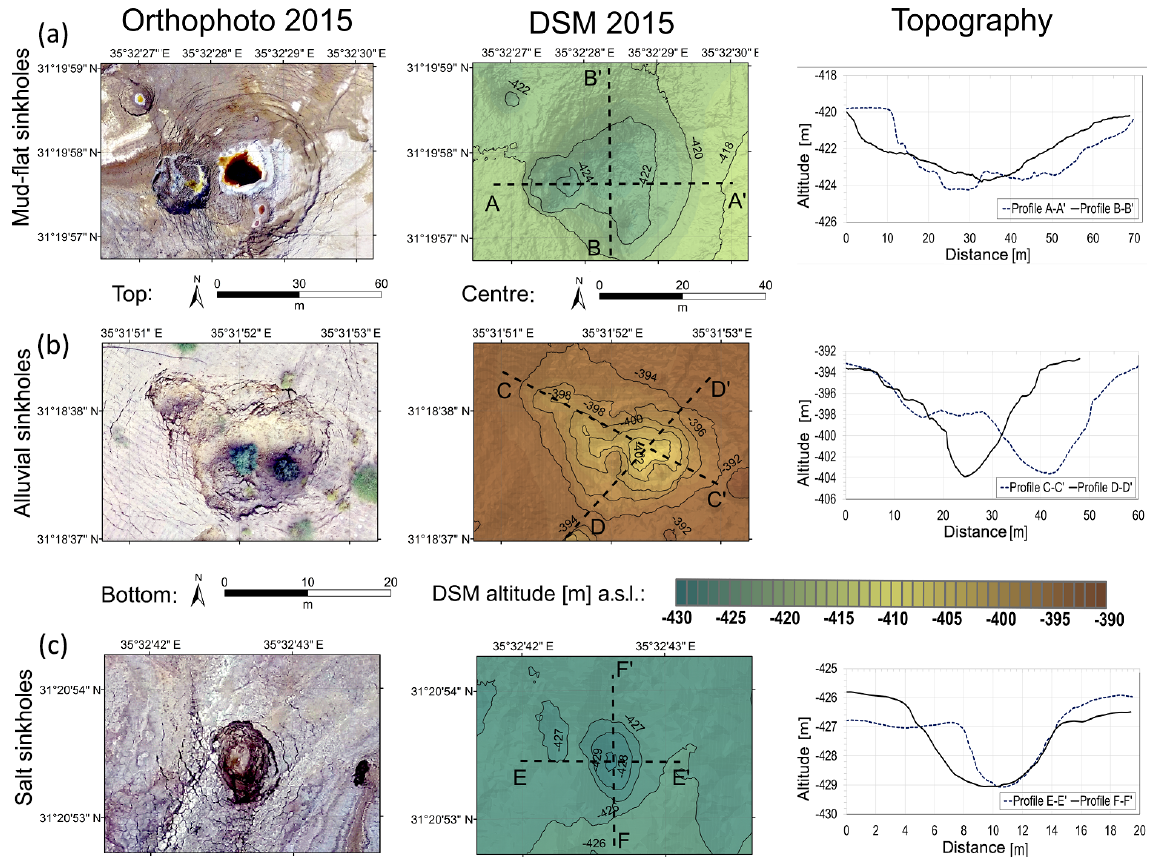
Figure 3. Representative morphological data from single sinkholes at the eastern shoreline of the Dead Sea: (a) in the mud flat, (b) in the alluvial material and (c) in the salt cover. Shown here are orthophotos (left column), digital surface models (DSMs, middle column) and topographic cross-sections (right column) with a resolution of 10cm and an accuracy of 12 and 17cm ( H and V ), respectively. These were created from low-altitude aerial images acquired in 2015 and processed by structure-from-motion photogrammetry. Contours of elevation in metres are indicated for clarity on the DSM, which is plotted in the same colour scale for all